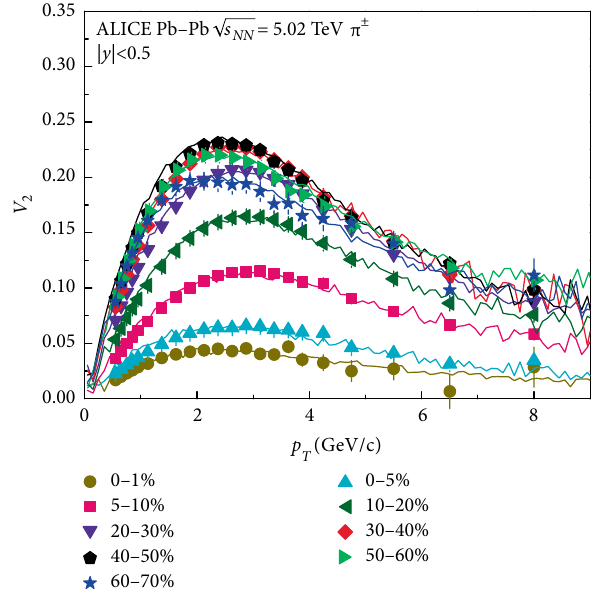
Figure 1: 𝑣 of 𝜋 ± in a given centrality interval arranged into 2 (𝑝 푇 ) panels of various centrality classes [36]. The data, which were measured by the ALICE collaboration in various centrality classes, are represented in the figure by different symbols. Statistical and systematic uncertainties are shown as bars. The curves are the results of this study fitted using the Tsallis-Pareto-Type function and the multisource ideal gas